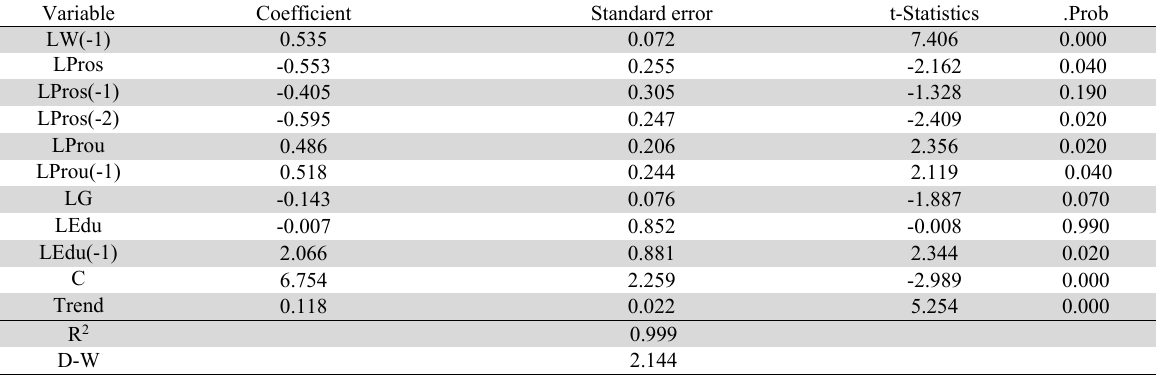
The short-run relationship between skilled and unskilled labor productivity and the level of wages with time trend